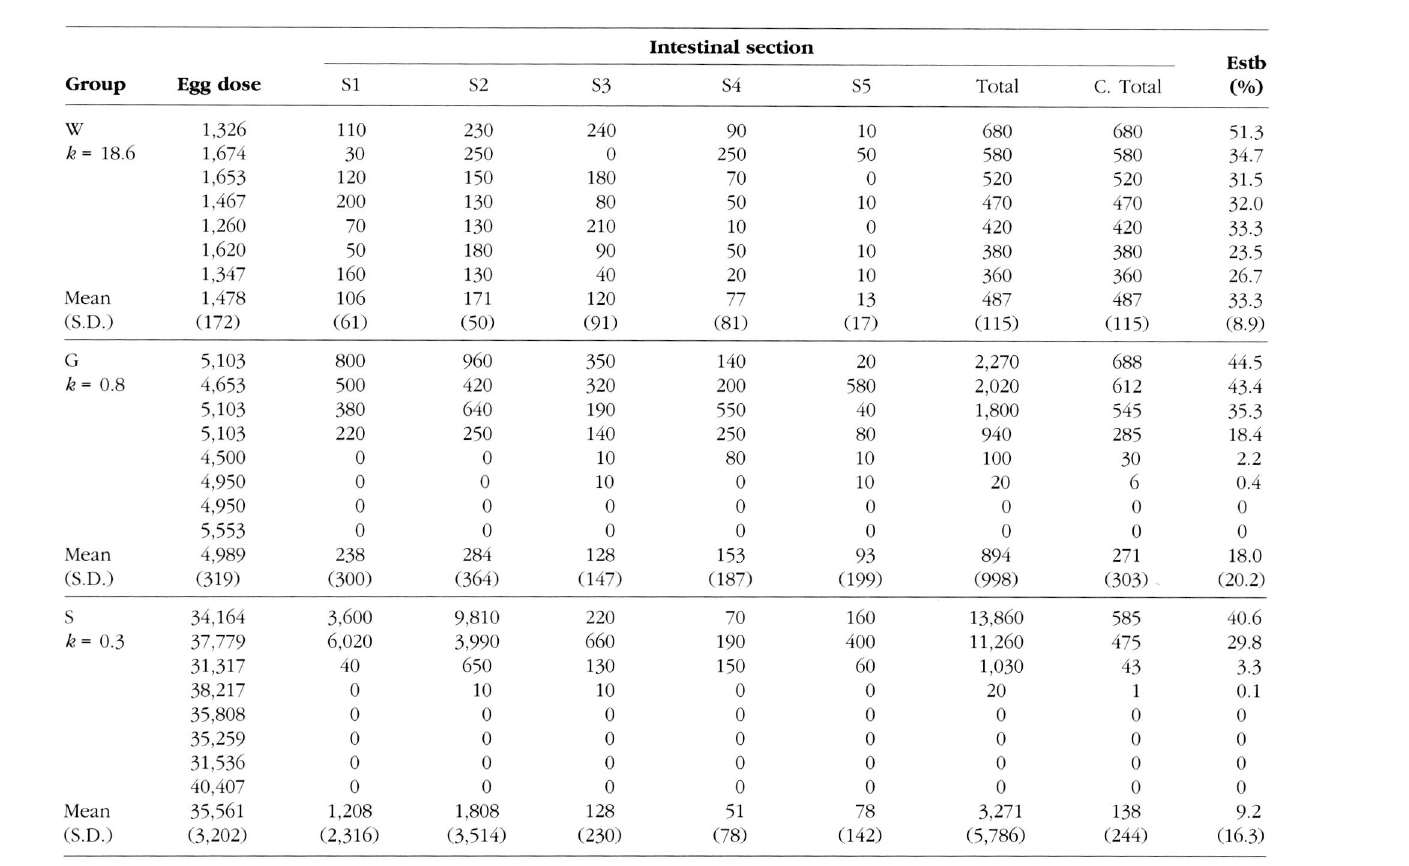
Table I. - Number of Trichuris suis recovered from the large intestine of weaner pigs (W), grower pigs (G) and sows (S) infected with 3 x 50 infective eggs per kg body weight and necropsied 10 weeks p.i. (SI) section 1 (caecum). (S2) section 2 (0-20 % of the total length of colon). (S3) section 3 (21-40 %). (S4) section 4 (41-60 %). (S5) section 5 (61-100 % including rectum). Total: all five sections. Corrected total to body weight. Infective egg dose administered orally. Percentage establishment (no. of worms recovered/no. of infective eggs admi­ nistered). The parameter k of the negative binomial distribution.